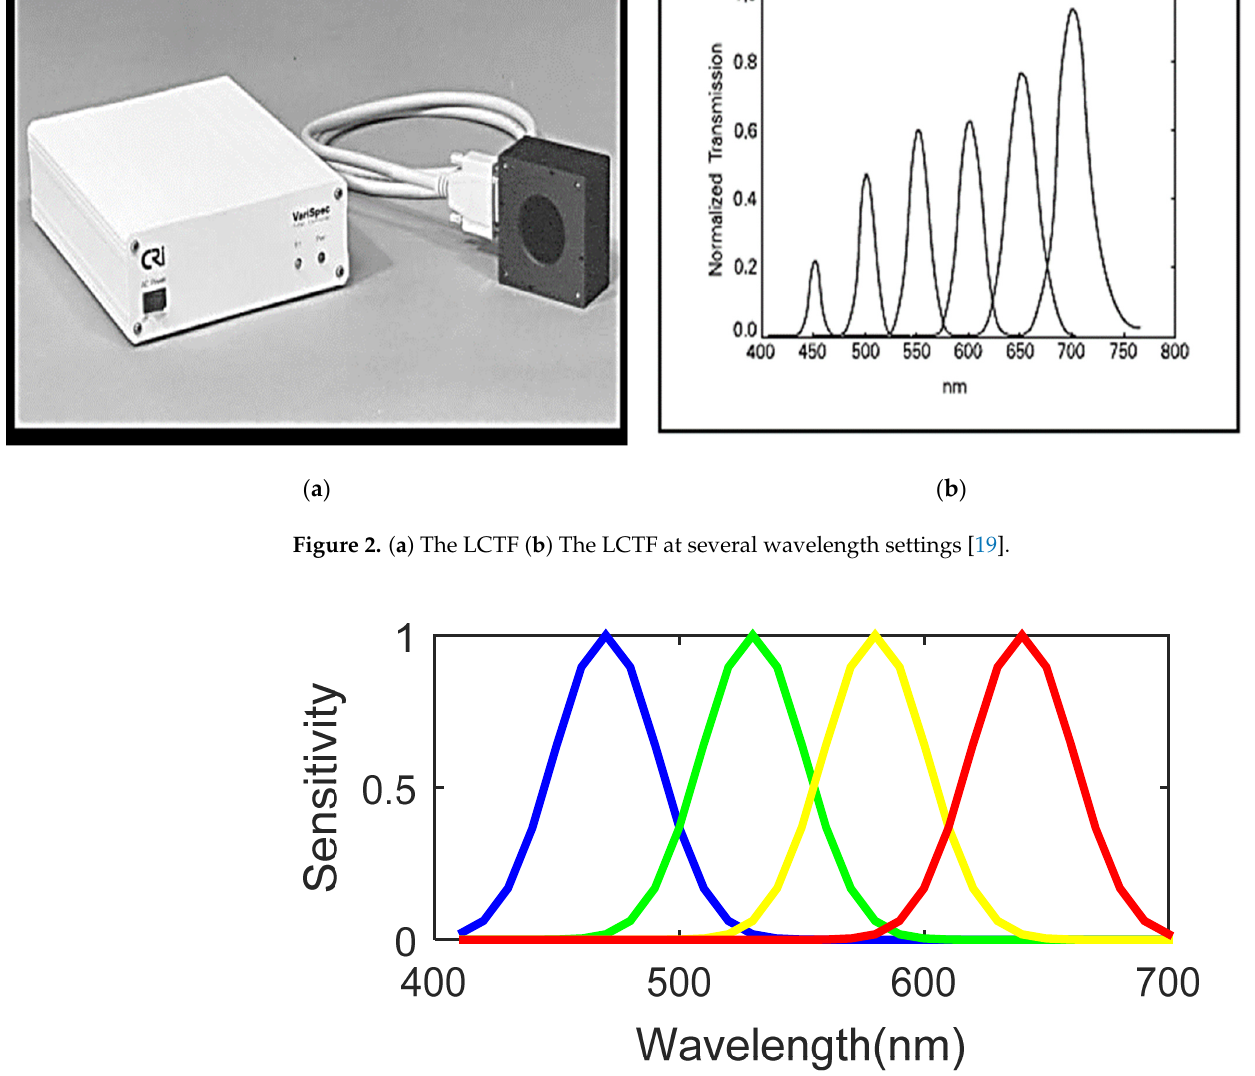
Figure 3. Spectral sensitivity of the 4 ‐ band filters.